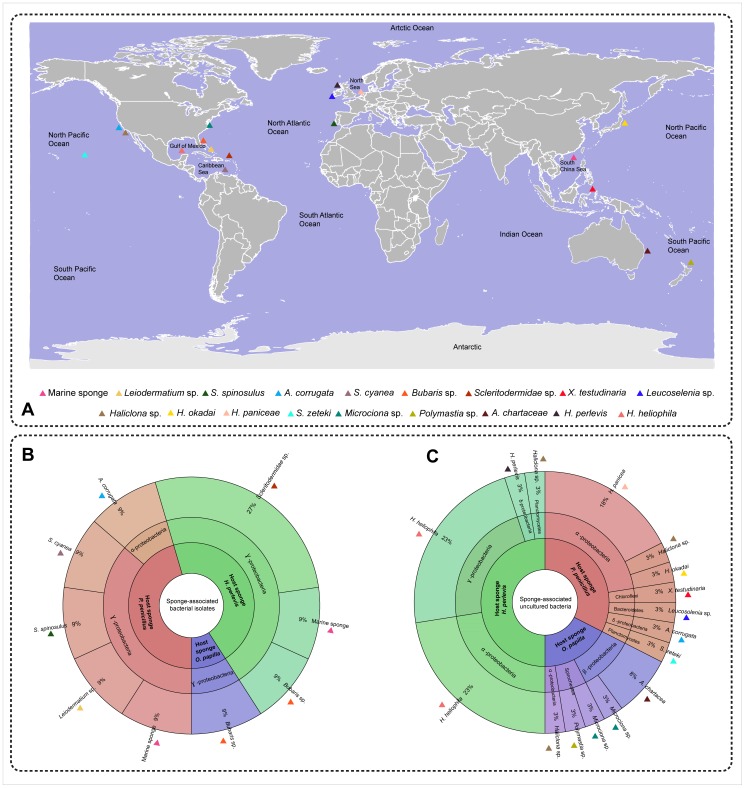
Sponge-associated bacteria among the host sponges H. perlevis, P. penicillus and O. papilla and its similarity with globally distributed related and unrelated host sponges.(A) Global map depicting the location of host sponges harboring bacterial assemblage similar to the retrieved microbes from the present study. Colored triangle on the map shows the sponge species from other studies. (B–C) Sponge associated bacteria from different hosts determined by isolation and uncultured techniques, represented as a pie chart [73] showing its abundance and affiliation with microbes found in association with globally distributed host sponges.